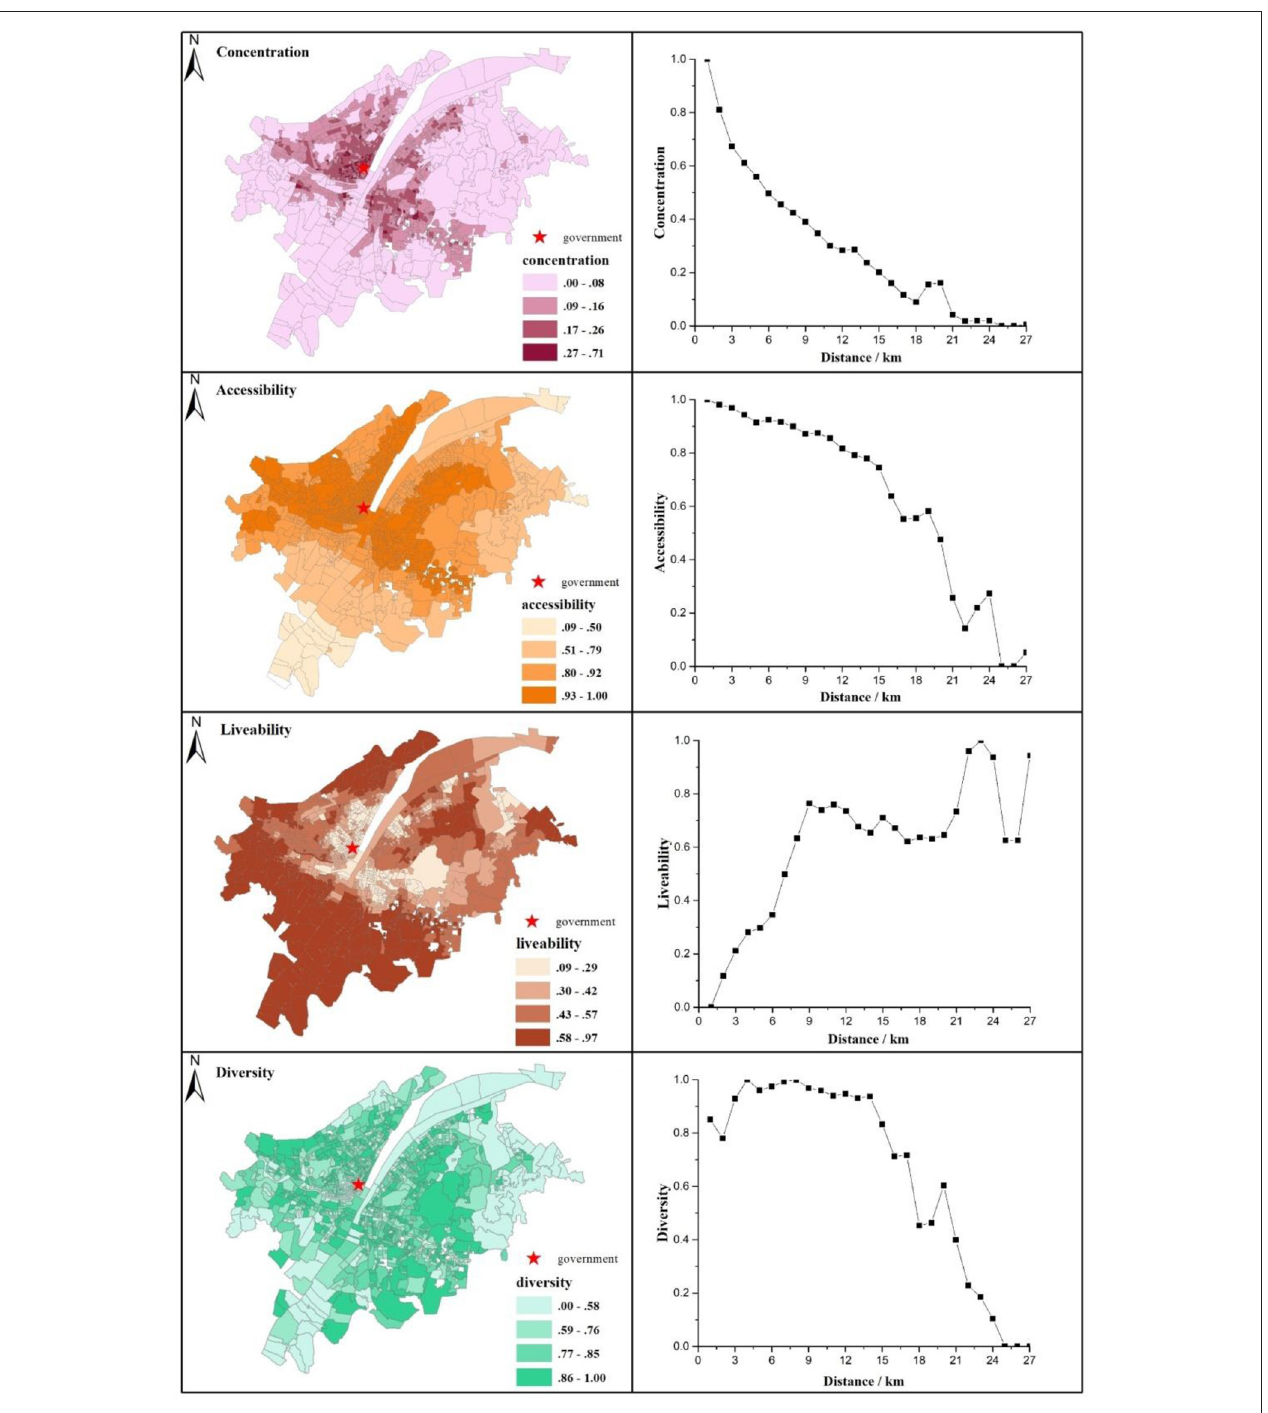
FIGURE 2 | Spatial pattern of concentration, accessibility, livability, and diversity (the left column) along with concentration, accessibility, livability, and diversity in concentric rings with the distance to the city center (the right column) in Wuhan.